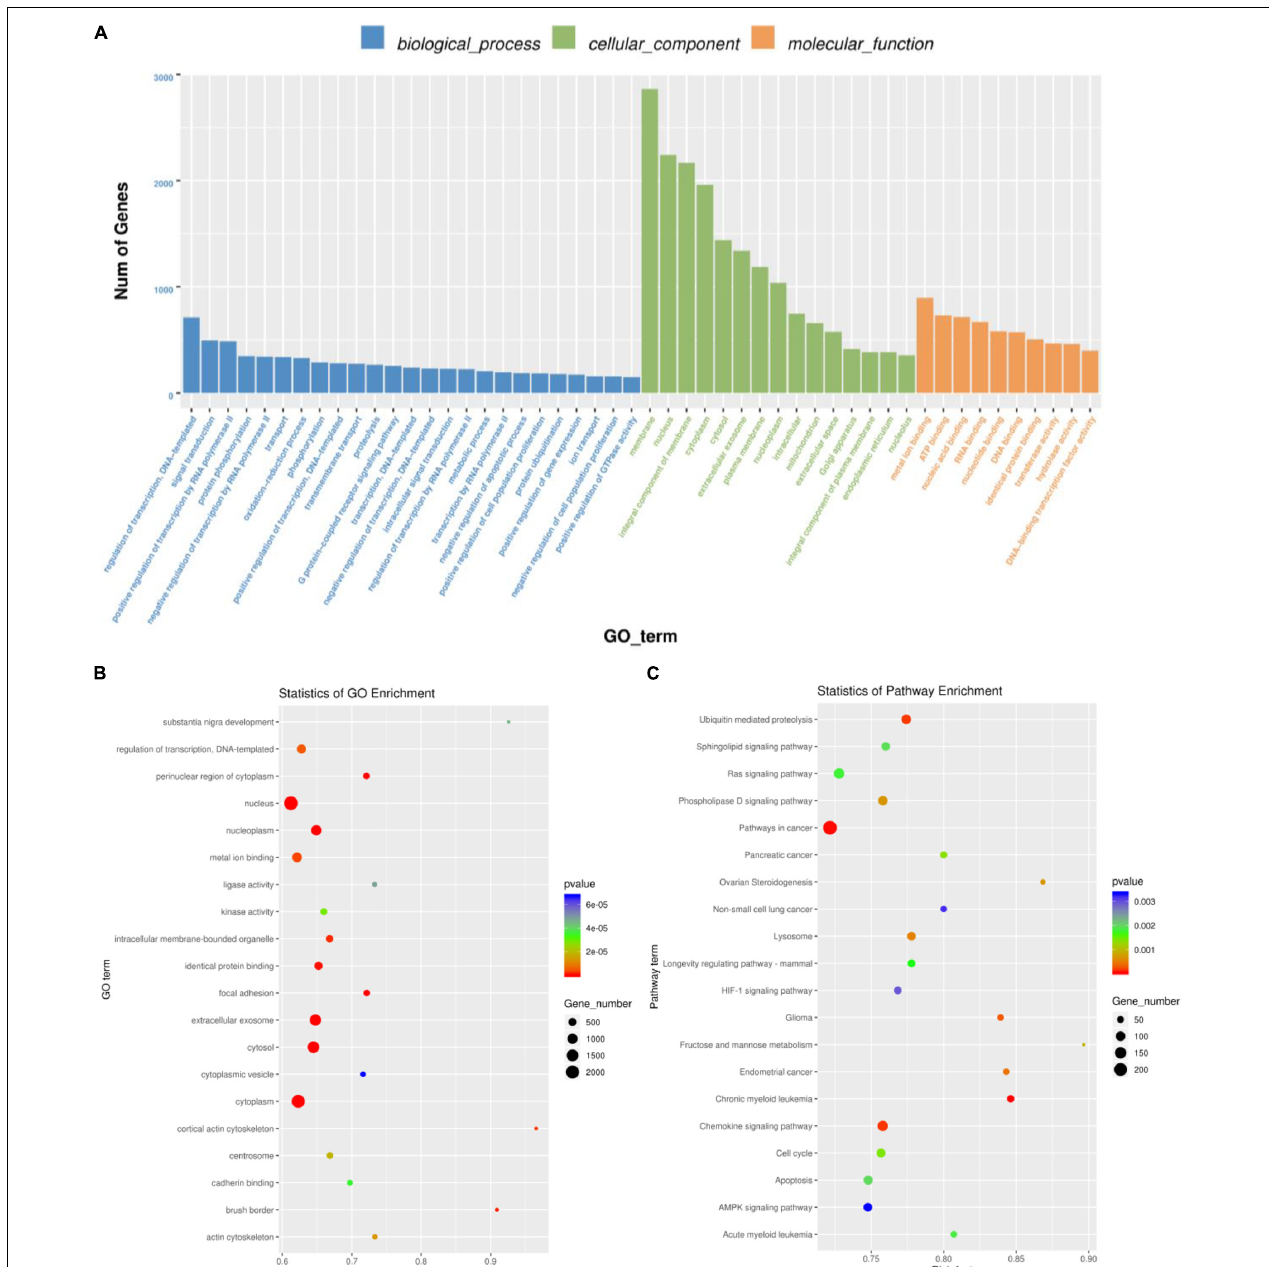
FIGURE 3 | Enrichment analysis of GO and KEGG pathways according to the target genes of differentially expressed miRNAs. (A) Top enriched terms of biological process, cellular component, and molecular function category in Gene Ontology enrichment analysis. The abscissa is the classification of GO, and the ordinate is the percentage of target genes. (B) Top 20 significantly enriched GO pathways of differentially expressed miRNAs-targeted genes. (C) Top 20 significantly enriched KEGG pathways of differentially expressed miRNAs-targeted genes. GO, Gene ontology; KEGG, Kyoto Encyclopedia of Genes and Genomes